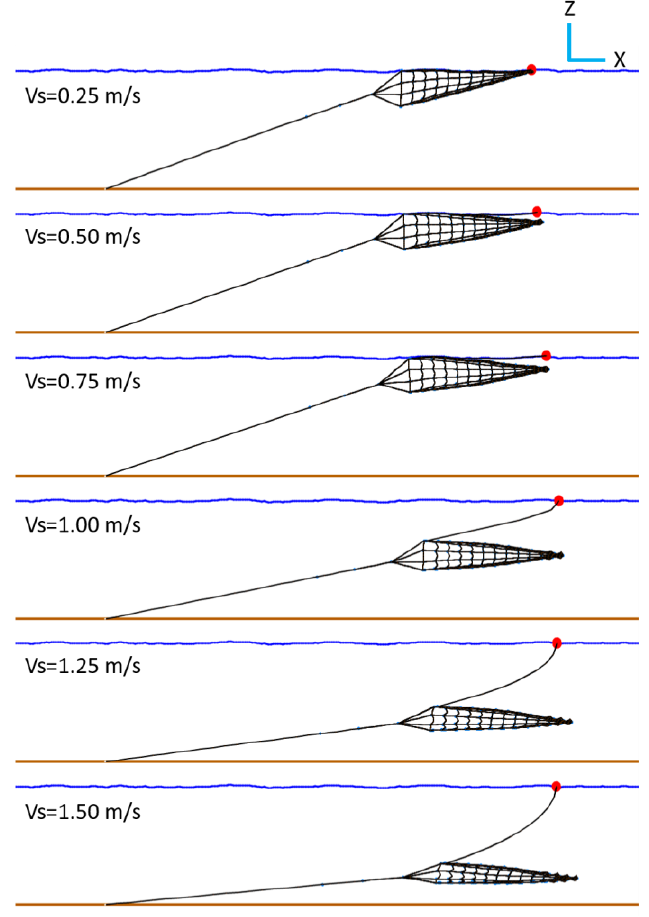
Figure 5. Snapshot of the entire stow net at varying current velocities under the same wave condition ( H s = 1.0 m, T p = 5.25 sec) at T = 1800 sec.